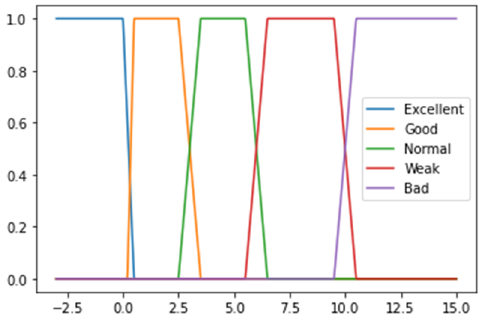
Figure 3. Membership functions using 5 thresholds for the Ruffier index (RFTest) evaluation.